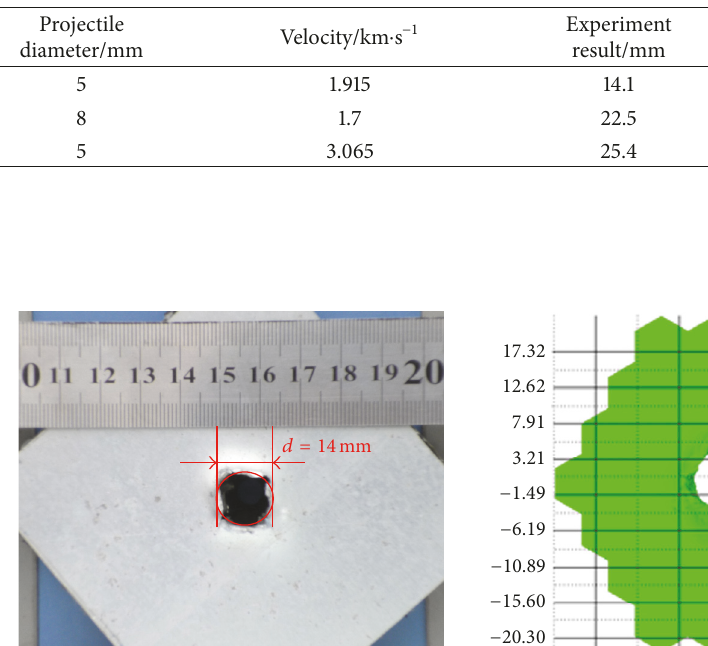
Table 3: Experiment and simulation results of rear face sheet of honeycomb sandwich panel.